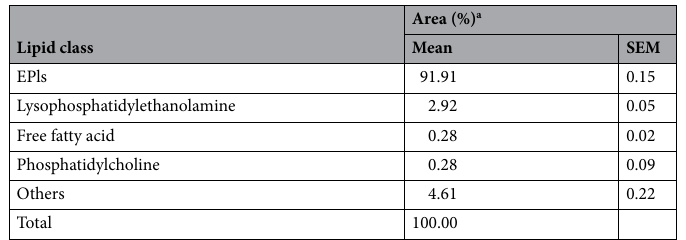
Table 1. Comparison of the peak area ratio of each lipid class to the total peak area of all lipids in scallop- derived EPls. a Ratio of the peak area of each lipid class to the total peak area. Triplicate analyses were performed for each lipid. EPl, ethanolamine plasmalogen; SEM, standard error of the mean.